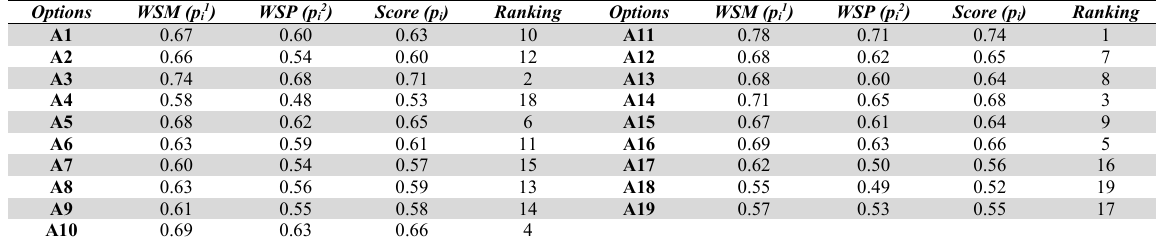
The WSM, WSP, the aggregated performance scores of the options and